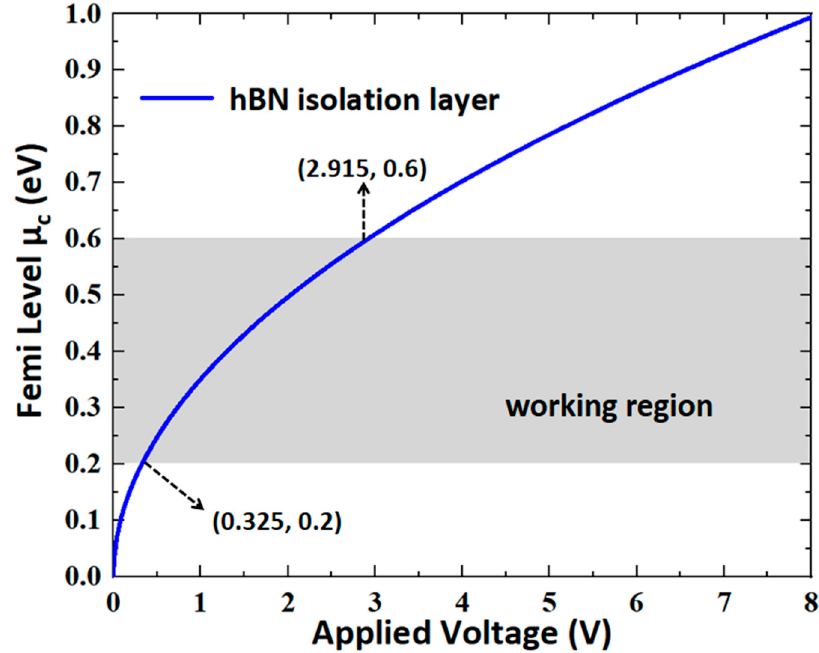
Figure 3. Graphene’s Fermi level variation with applied